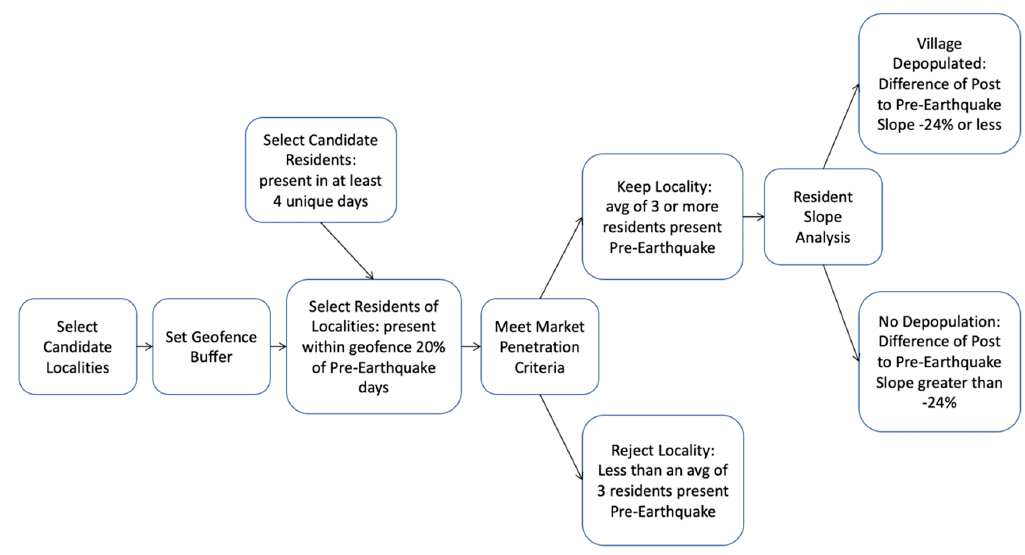
Figure 5. In the analytic workflow, following the geofence (Section 2.3), residents of the villages were established (Section 2.4.3). Only villages with at least 3 residents (Section 2.4.4) were analyzed to detect if they experienced a depopulation after the earthquake (Section